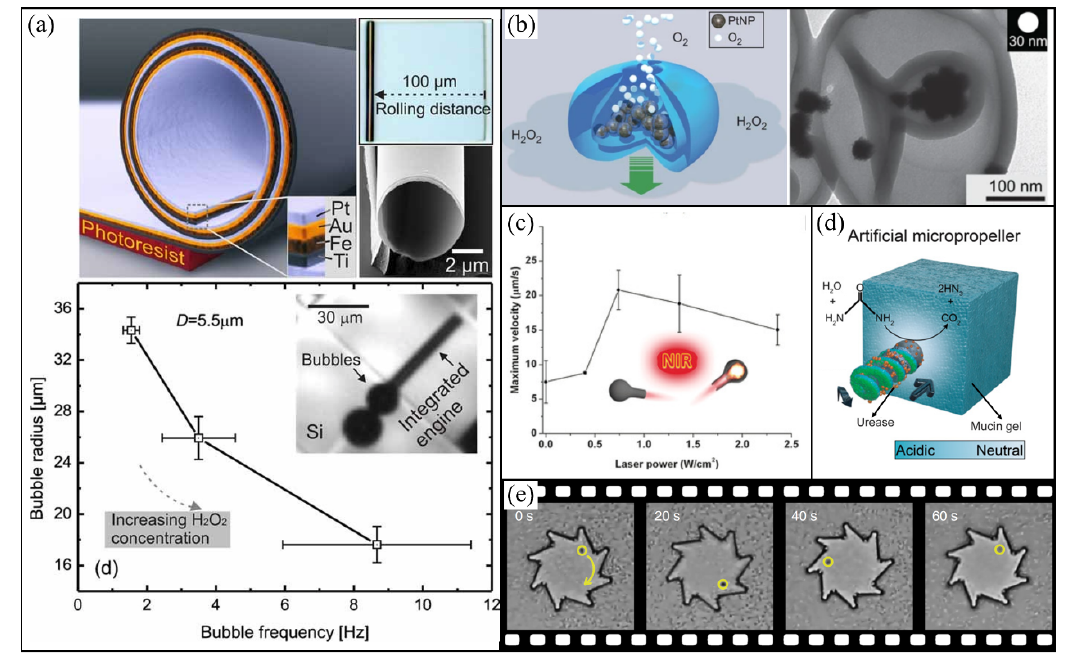
Figure 3. Examples of microjets and chiral motors. ( a ) Microtubular motors fabricated by a rolling-up technology. Reprinted with permission from [113]. ( b ) An illustration of a polymer stomatocyte and its transmission electron microscope image. Reprinted with permission from [119]. ( c ) Carbonaceous nanobottles’ velocity as a function of light intensity. Reprinted with permission from [123]. ( d ) Magnetic powered micropropellers decorated with urease can drill into mucin gel. Reprinted with permission from [128]. ( e ) Bacteria-driven rotation of microgears. Reprinted with permission from [130].